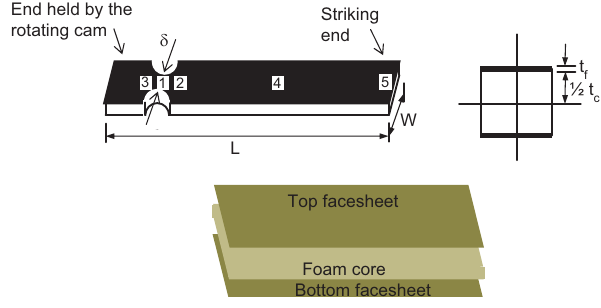
Figure 3 Specimen configuration: [1] – [5] represent the locations of the strain gauges, whereas pressure transducers were placed at locations [3] – [5] on model specimens.